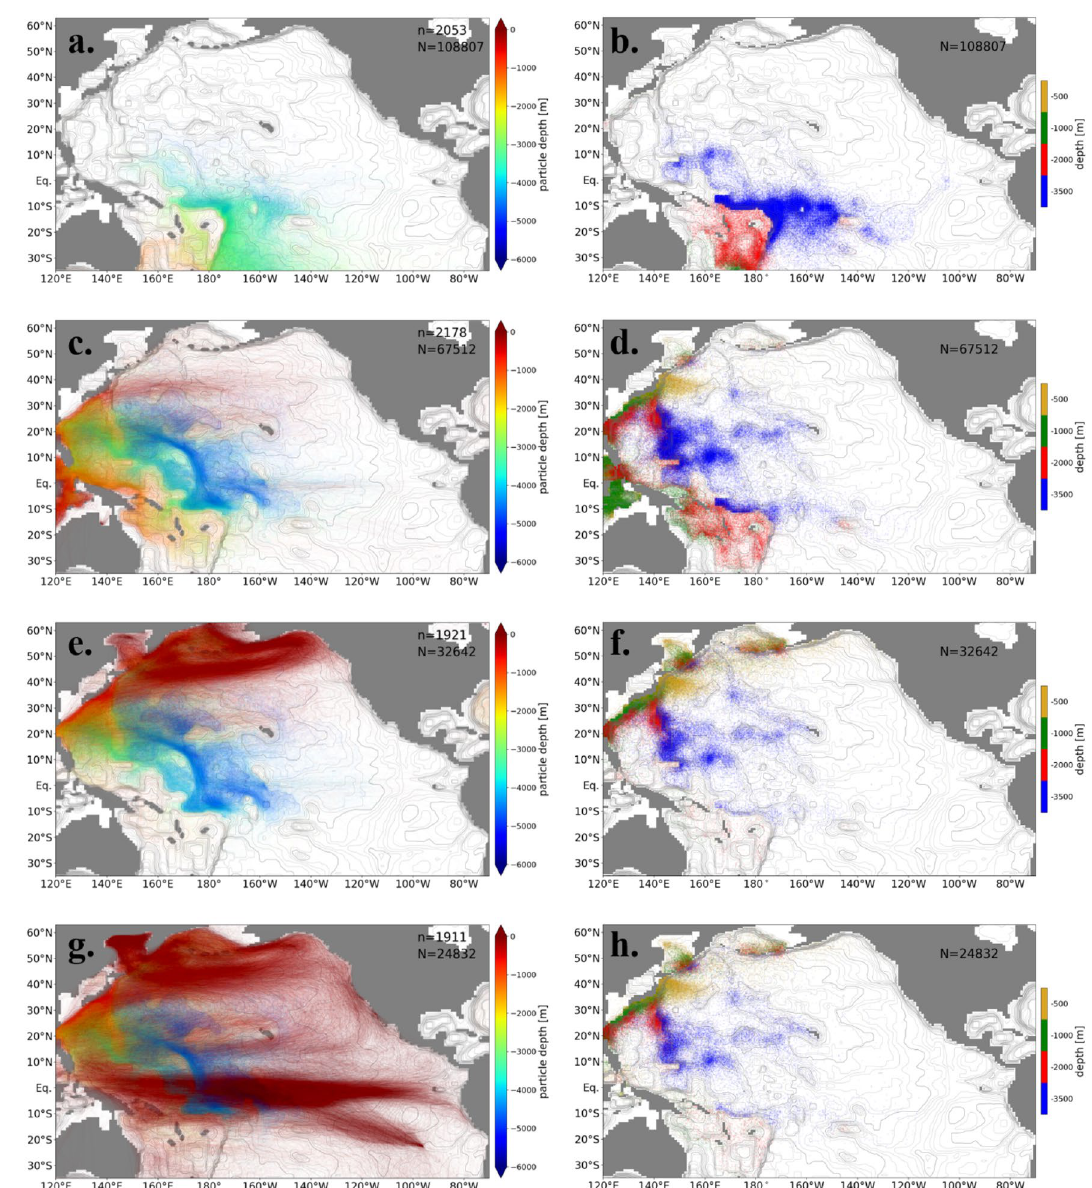
Figure 3. The pathways defined by the earliest 10% of the particles that leave from the Pacific Ocean to each destination. Left-hand panels show trajectories of the particles. Colors indicate depths. The numbers of total particles (N) and plotted particles (n) are written in the panels. The right-hand panels show the horizontal positions where particles first cross the 500 (yellow), 1000 (green), 2000 (red), and 3500 m depths (blue). The destinations are ( a, b ) the Southern Ocean, ( c, d ) the Indian Ocean, ( e, f ) the Arctic Ocean, and ( g, h ) the atmosphere particles ascend in the Melanesian Basin or Southwest Pacific Basin and reach the Southern Ocean through the South Fiji Basin and the Tasman Sea (Fig. 3a and b), which corresponds to the Tasman leakage 22 . Except for the shallow layer (< 500 m depth), a majority of particles reaching the Indian Ocean through the Indonesian Archipelago are transported in the western North Pacific Ocean, not in the east (Fig. 3c). The particles are transported in the Central Pacific Basin or the Melanesian Basin in the bottom layer, then join and ascend to the deep layer at the Izu-Ogasawara Ridge where turbulent vertical mixing is strong (Fig. 3c and d). These particles ascend to the intermediate layer (500–1000 m depth) at the Luzon Strait (around 20°N, 120°E) and around the Ryukyu Islands and are transported to the Indonesian Archipelago (Fig. 3c and d). The particles on the secondary pathway ascend to the deep layer in the Melanesian Basin and to the intermediate layer in the Solomon Sea or North/South Fiji Basin and reach the Indonesian Archipelago (Fig. 3c and d). The trajectories and ascending points of most of the particles reaching the Arctic Ocean are similar to those reaching the Indian Ocean in the deep and bottom layers (Fig. 3e and f). In the shallow and intermediate layers,